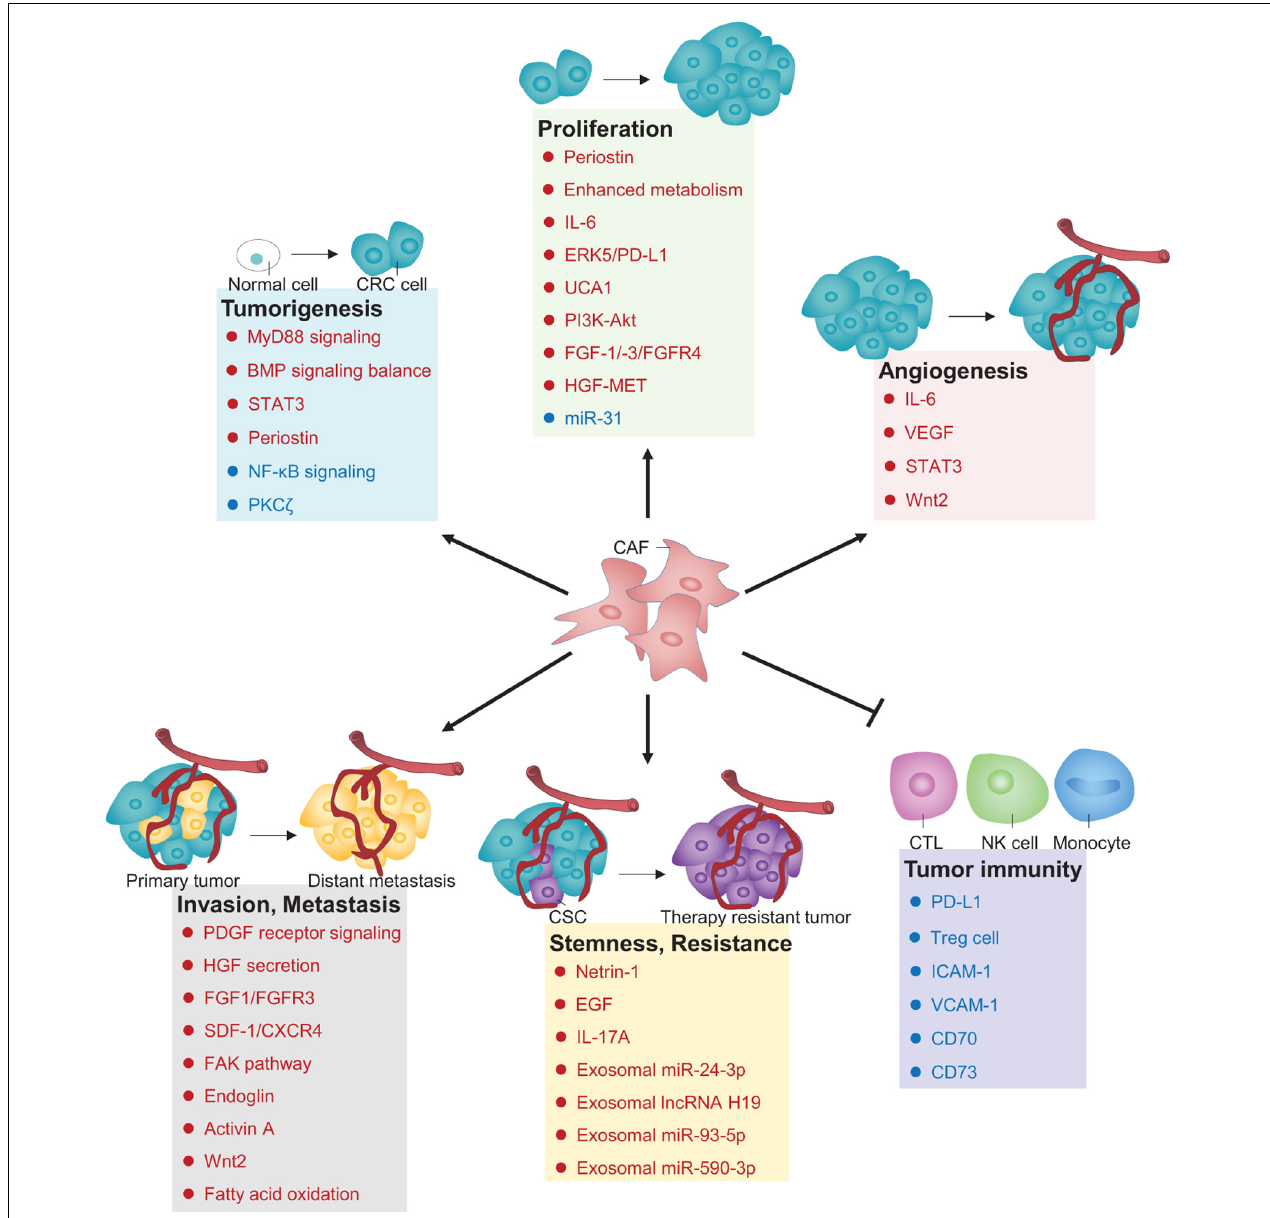
FIGURE 1 | Principal roles and related mechanisms of CAFs in CRC hallmarks. Those depicted in deep blue are negative regulators, whereas those depicted in red are positive regulators controlling CAFs’ roles in CRC. CTL, Cytotoxic T lymphocyte; NK cell, natural killer cell; PD-L1, programmed death ligand 1; Treg cell, regulatory T cell; ICAM-1, Intercellular adhesion molecule-1; VCAM-1, Vascular cell adhesion